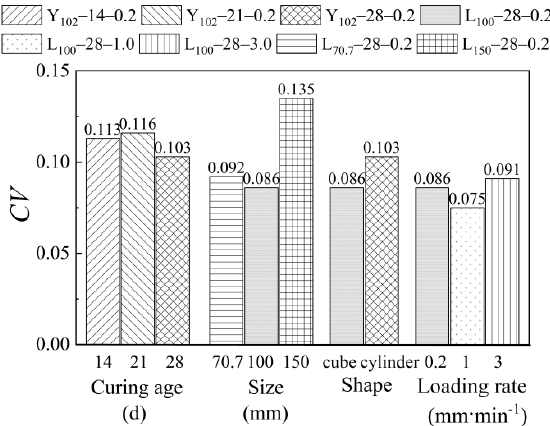
Figure 9. Coefficient of variation of compressive strength of specimens under different working conditions.